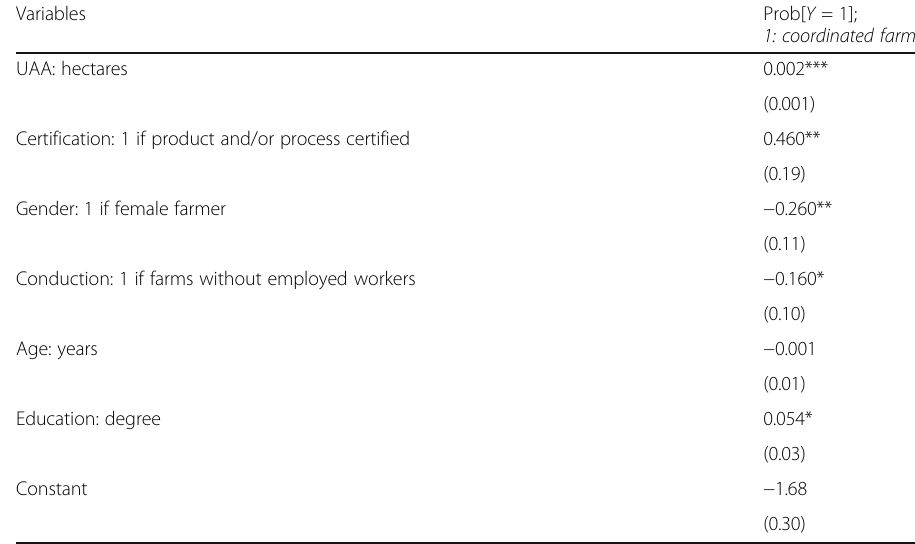
Table 2 Vertical coordination participation model (probit with regional fixed effect) Variables